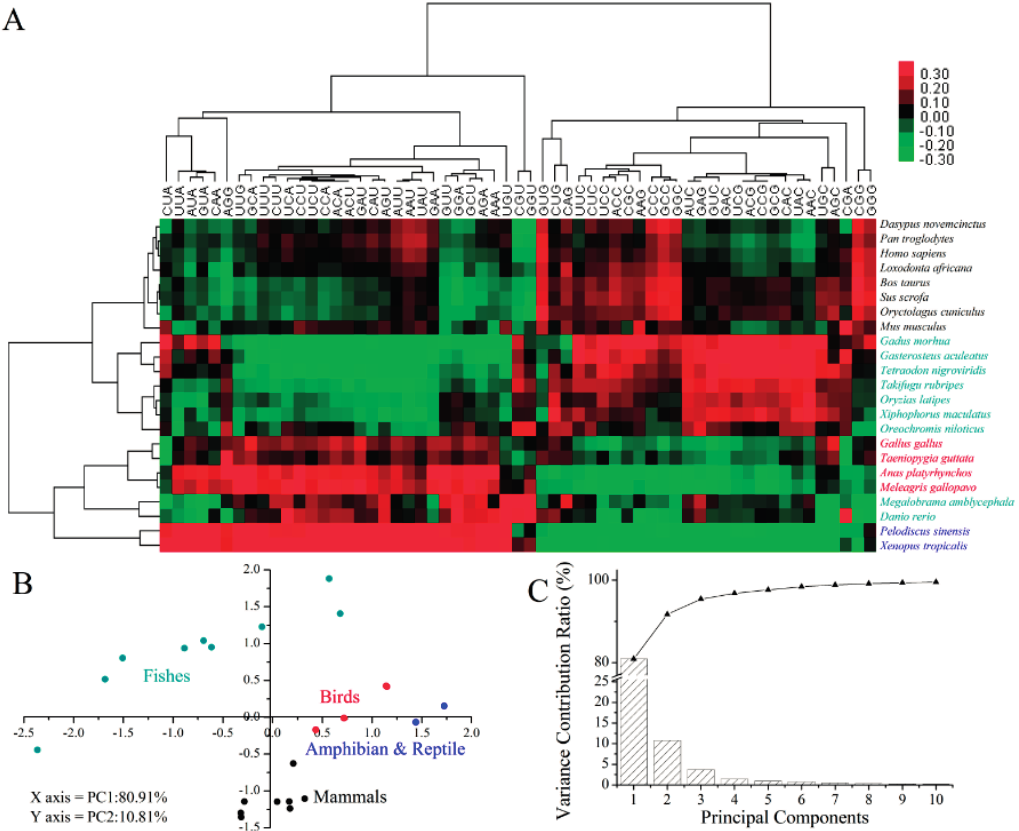
Figure 7. Heat map and PCA analysis of RSCU of synonymous codons from 23 vertebrate species. ( A ) Heat map of adjusted RSCU of 59 codons from 23 species using Euclidean distance and average linkage clustering module; ( B ) The PCA analysis of RSCU of 59 codons from 23 species on the primary and secondary axes (accounting for 80.91% and 10.81% of the total variation, respectively). Dark cyan, blue, red, black represent the fishes, reptile together with amphibian, birds and mammals, respectively; ( C ) Variance contribution ratio (bar) and accumulated variance contribution ratio (triangular plot) of the first ten principal components ( X -axis) of ( B